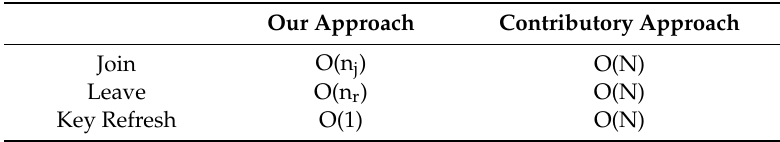
Table 6. Overall communication overhead where n j is the number of joining inverters, and n r is the number of non-evicted group